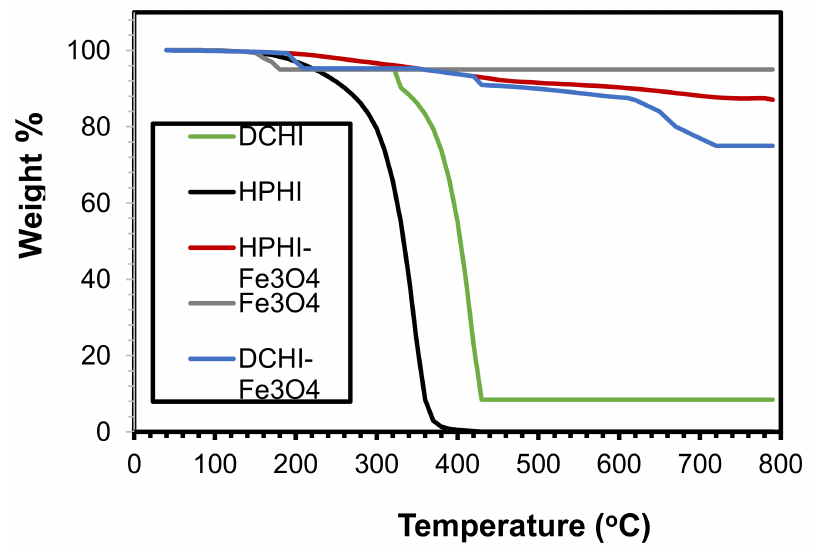
Figure 6. Thermogravimetric analysis (TGA) thermograms of HPHI, DCHI, HPHI-Fe 3 O 4 , and DCHI-Fe 3 O 4